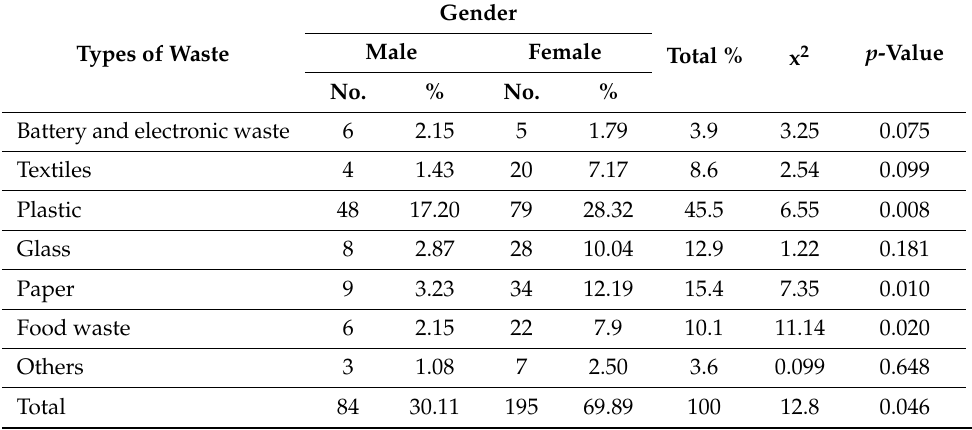
Table 6. Types of waste generated by households ( n = 279).